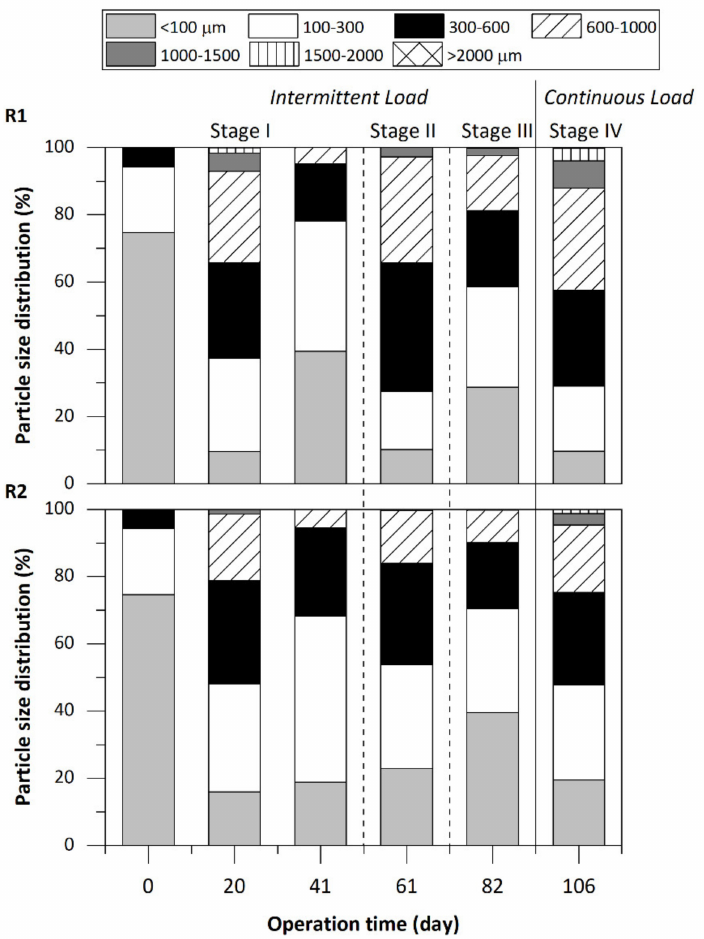
Figure 4. Evolution of the particle size distribution. ( a ) R1, operated at U L ≤ 0.15 m h − 1 , ( b ) R2, operated at U L = 3.0 m h − 1